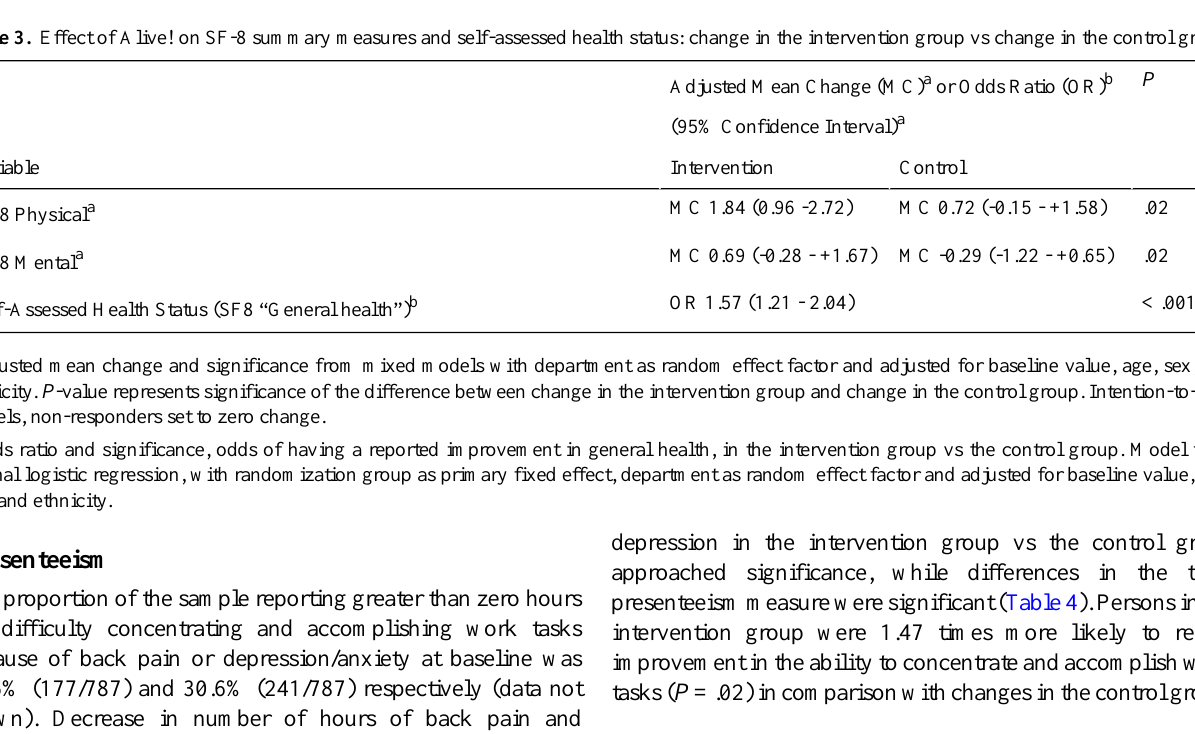
Table 3. Effect of Alive! on SF-8 summary measures and self-assessed health status: change in the intervention group vs change in the control group